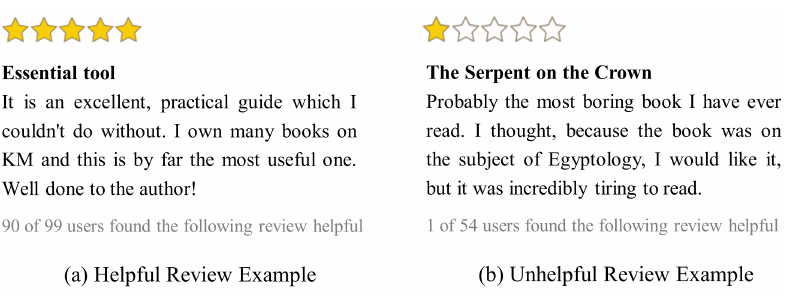
Figure 3. Distributions of helpfulness scores.